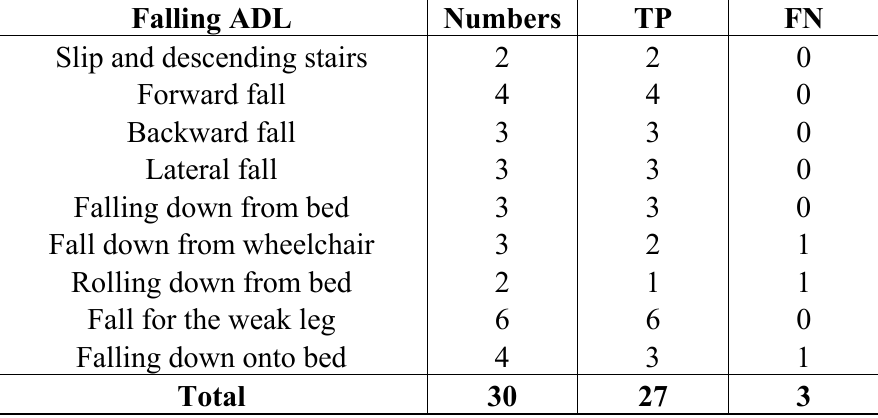
Table 9. The analysis of different falling ADL detections in a continuous unscripted ADL